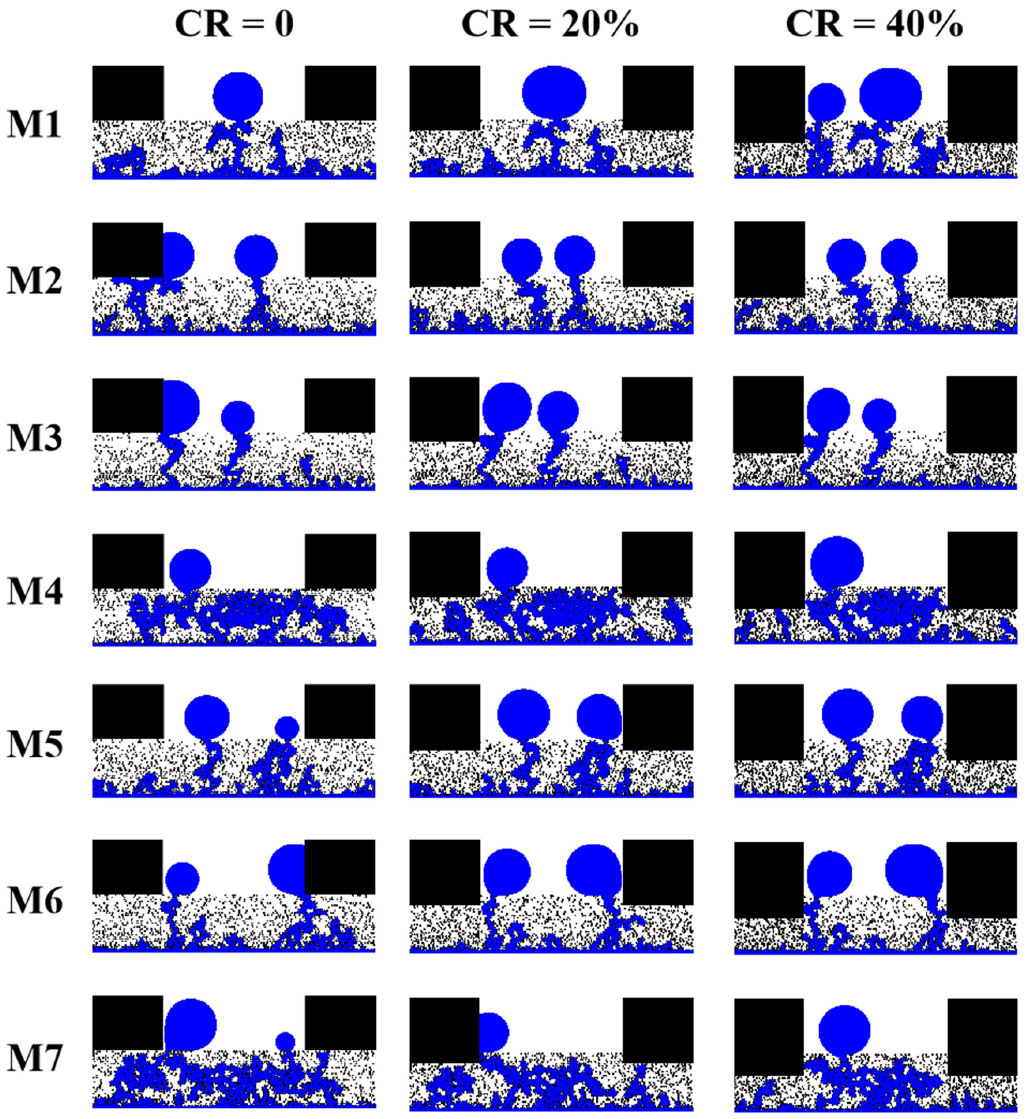
Figure 7. The liquid water distribution at steady state for the seven different porosity gradients of GDL considered at CR = 0, 20%, and 40%.